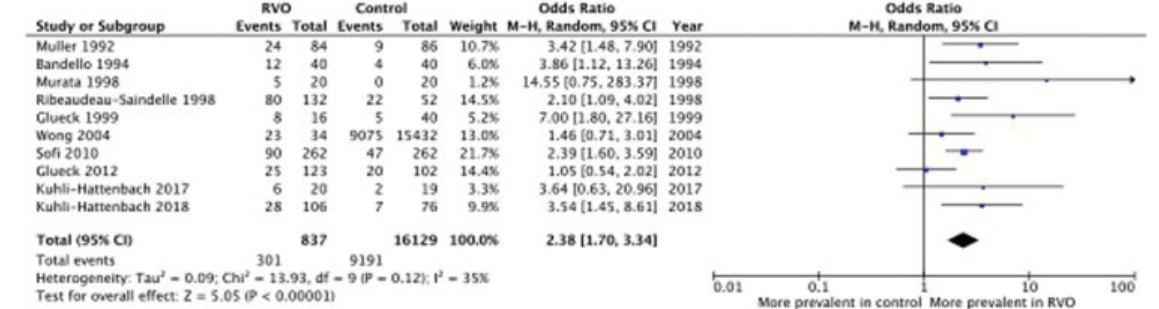
Fig. 2 Prevalence of RVO in subjects with abnormal Lp(a) versus Lp(a) within normal range. Forest plot of the studies in which abnormal Lp(a) was de fi ned by values above a prespeci fi ed upper normal limit. CI, con fi dence interval. Lp(a), lipoprotein (a); RVO, retinal vein occlusion.